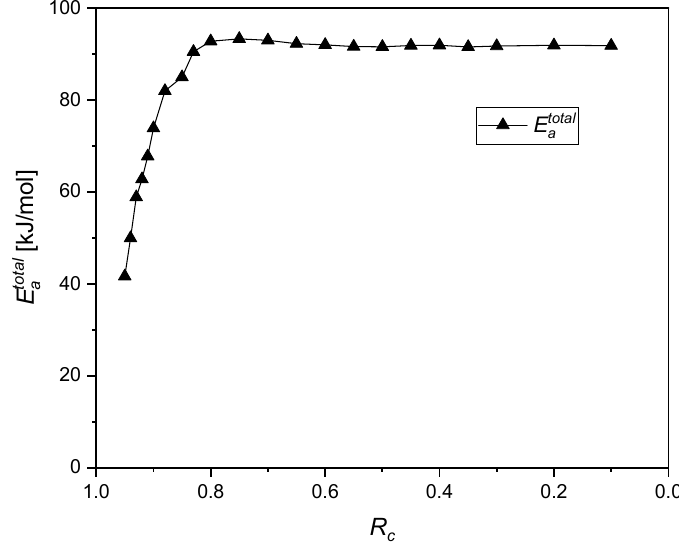
Figure 12. The evolution of the total activation energy E total a as a function of the normalized continuous stress relaxation R c .